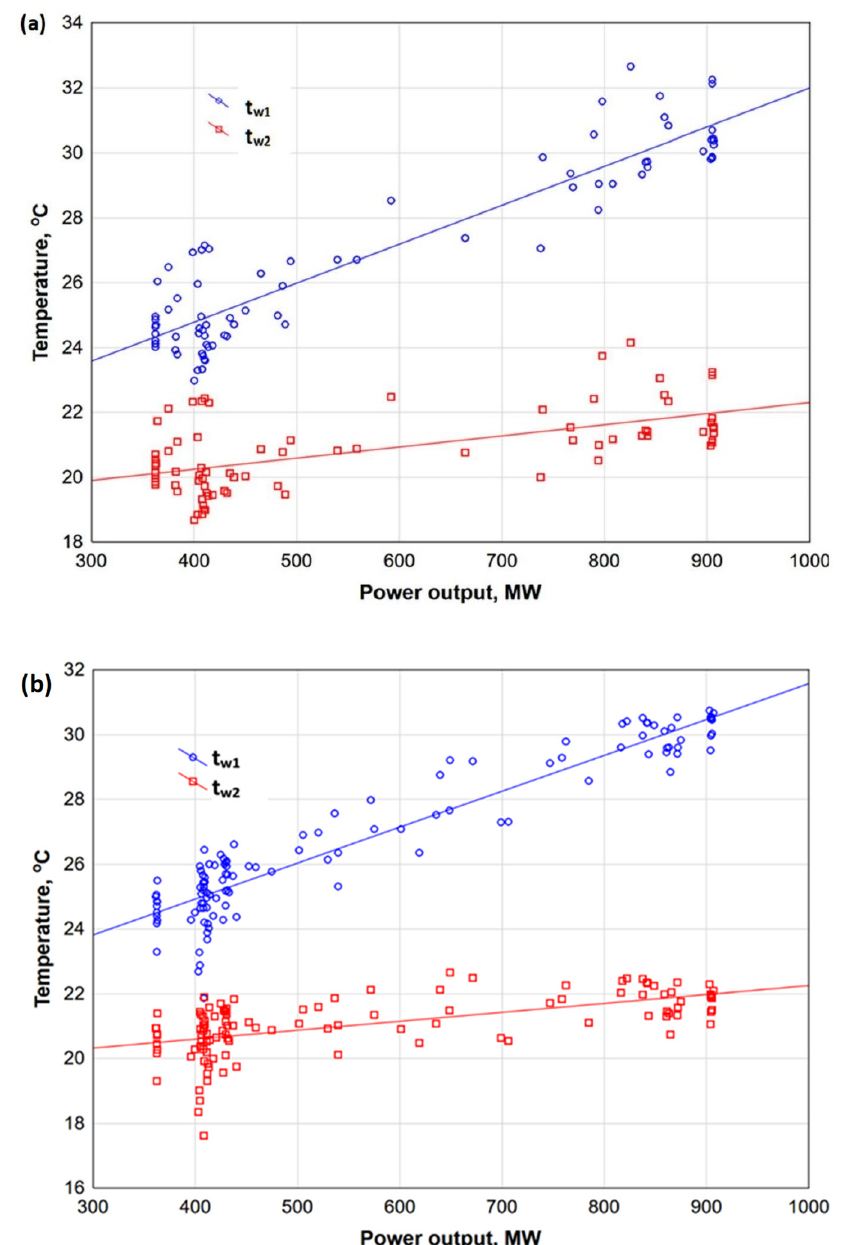
Figure 9. Temperatures t w 1 and t w 2 as a function of unit power output and T amb =15 ± 1 ◦ C, ϕ = 70 ± 5%: ( a ) for power unit 5; ( b ) for power unit